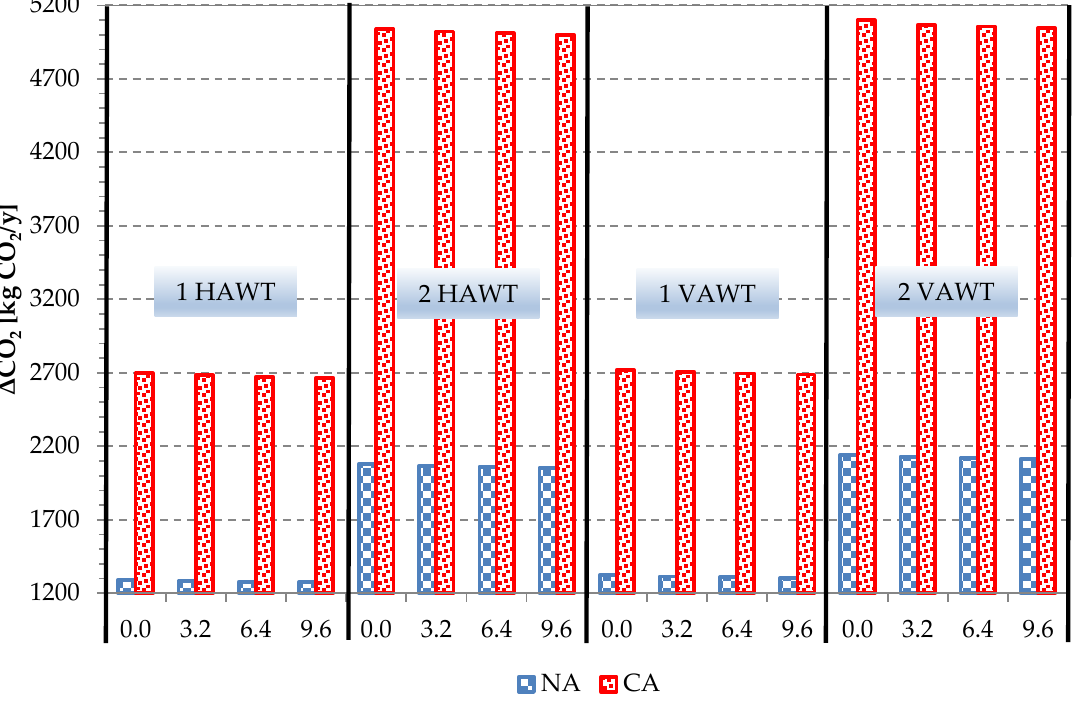
Figure 15. Carbon dioxide emission reduction for both Naples and for Cagliari, as well as for WT configuration and battery size.